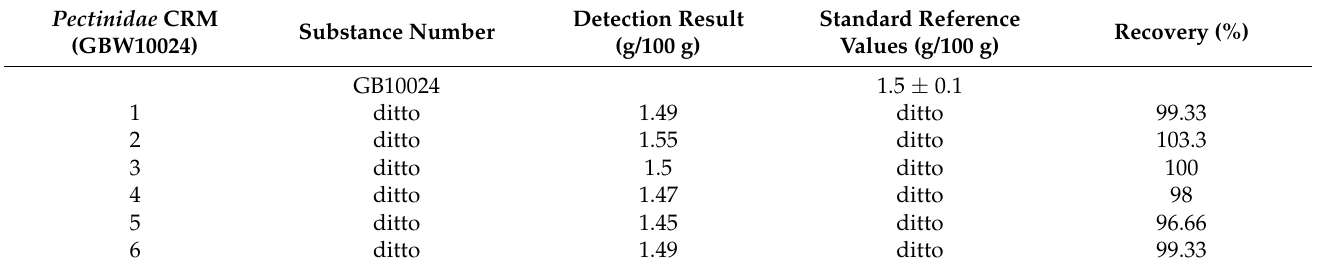
Table 5. Results of S recovery rate (%) in Chlamys farre standard substances (n = 6).